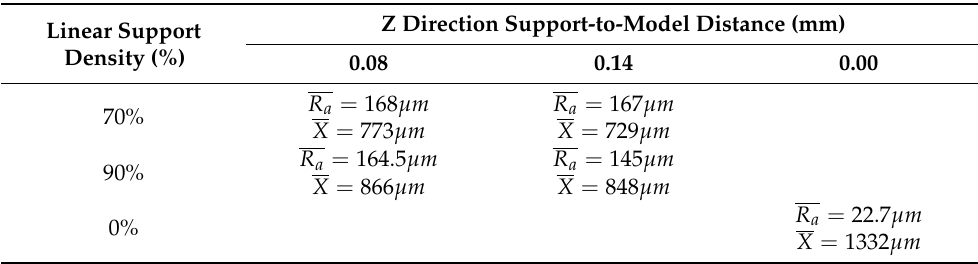
Table 3. Measurement results for two adjacent gratings of unsupported printing members and printing members with linear support under different conditions.